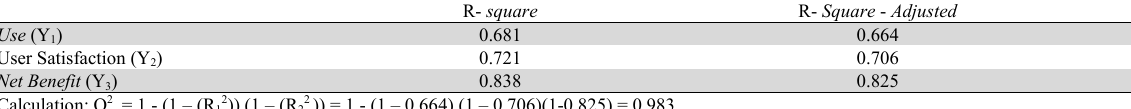
R-square and Q-square test results